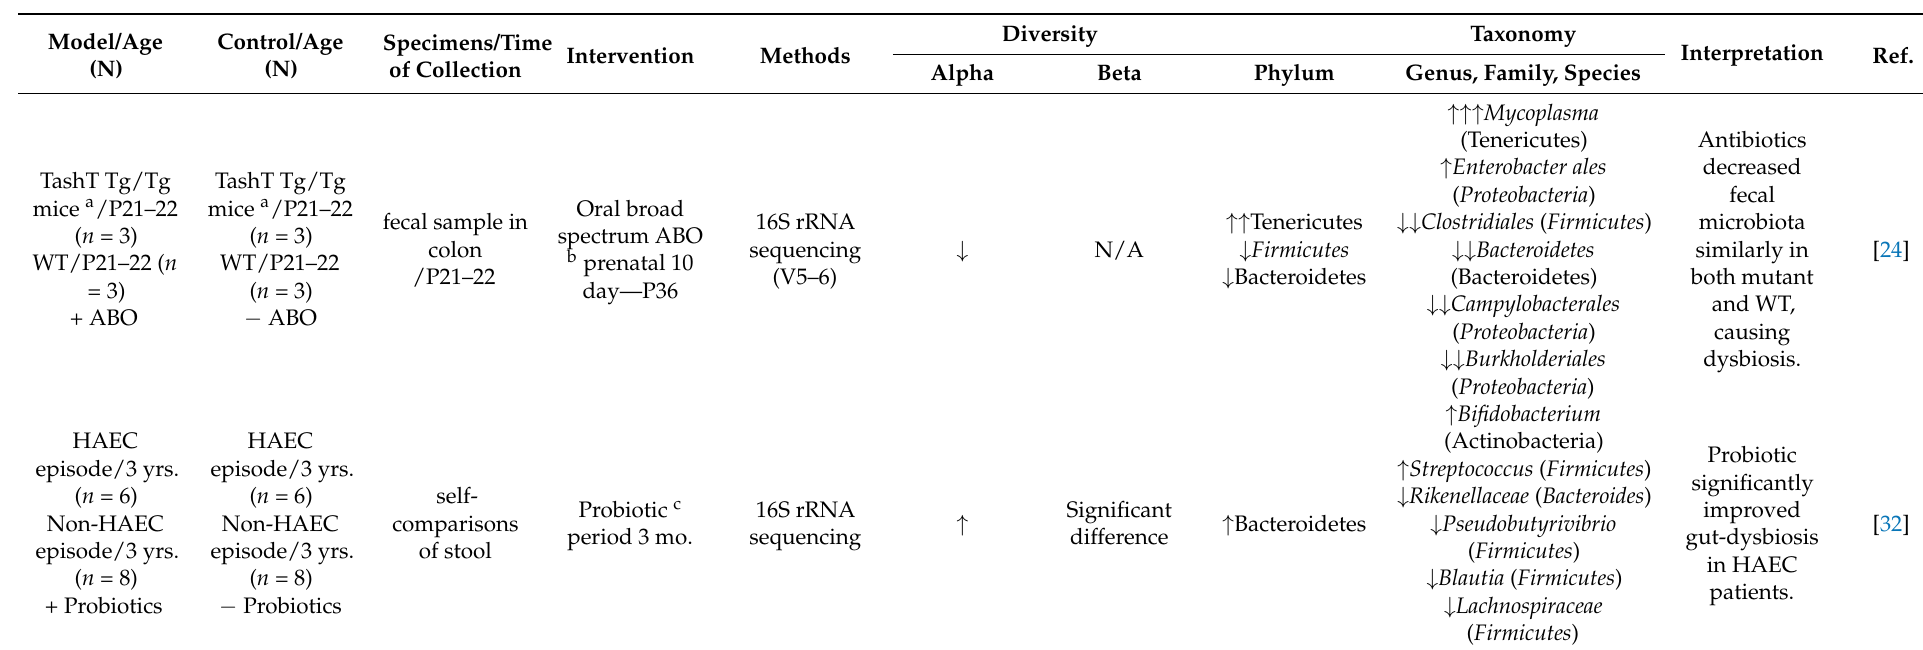
Table 5. The alterations in gut microbiota following interventions: evidence from animal to clinical